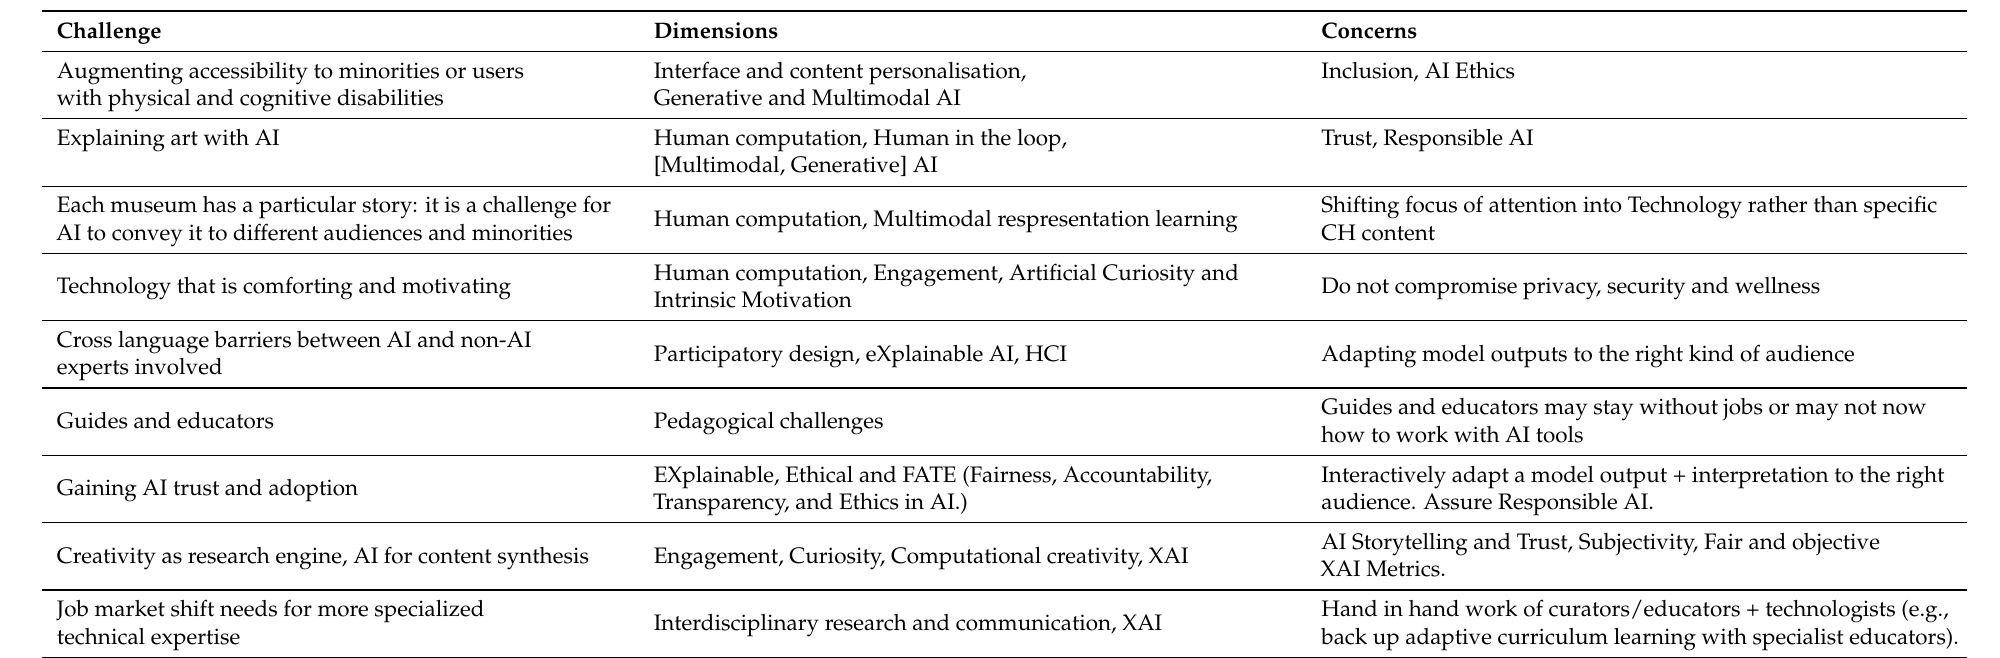
Table 2. Challenges to tackle to leverage (X)AI for Cultural Heritage